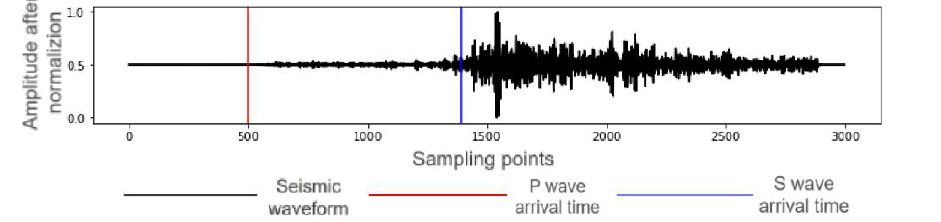
Figure 6. An original waveform (the red vertical line represents the arrival of the P wave and the blue vertical line represents the arrival of the S wave).